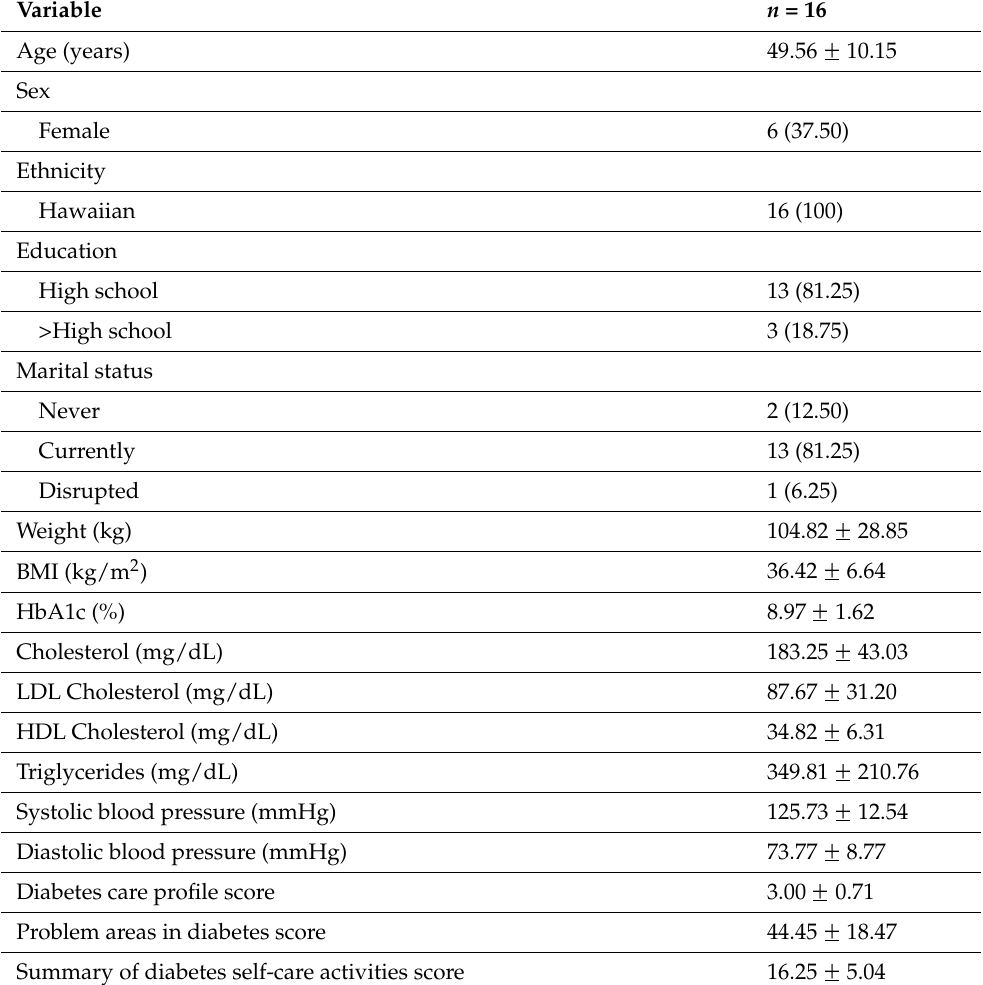
Table 1. Participants’ baseline socio-demographic, behavioral, and biological